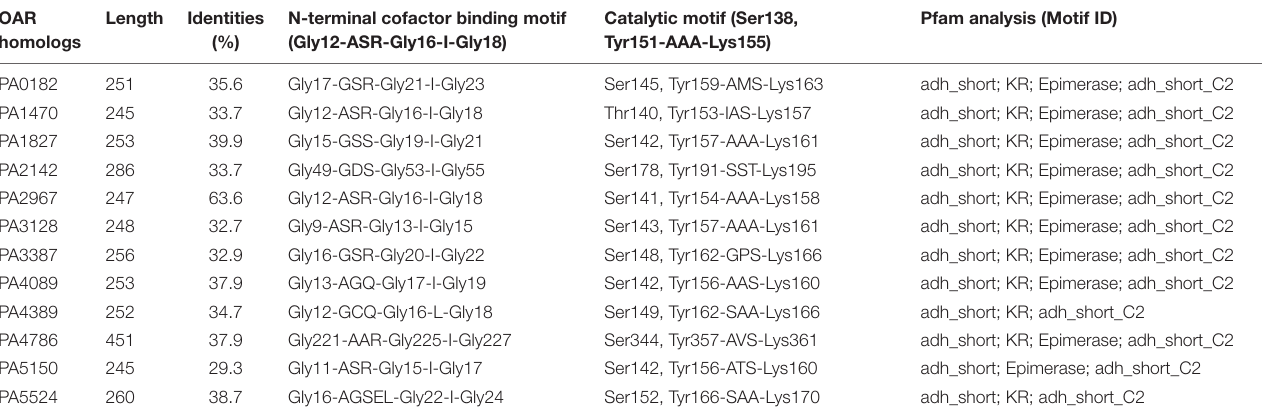
Pfam analysis (Motif